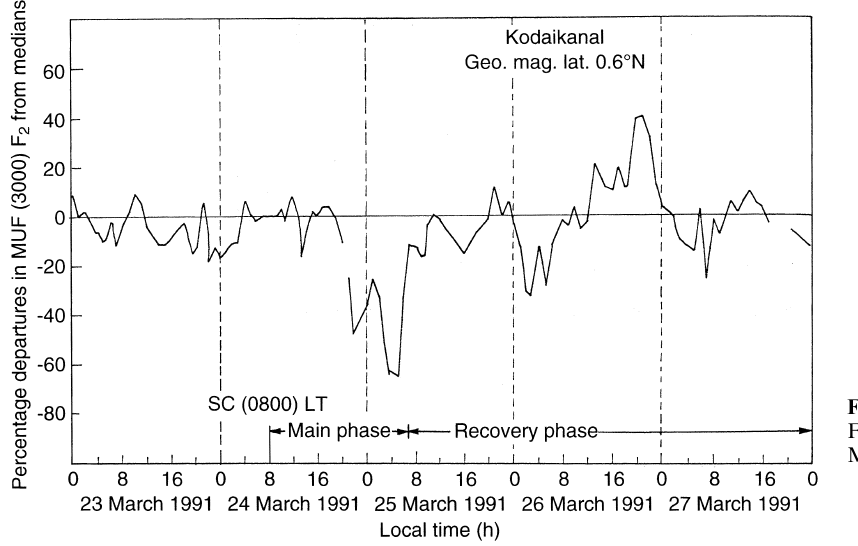
Fig. 5. Percentage departures in MUF (3000) F2 values from their monthly values during